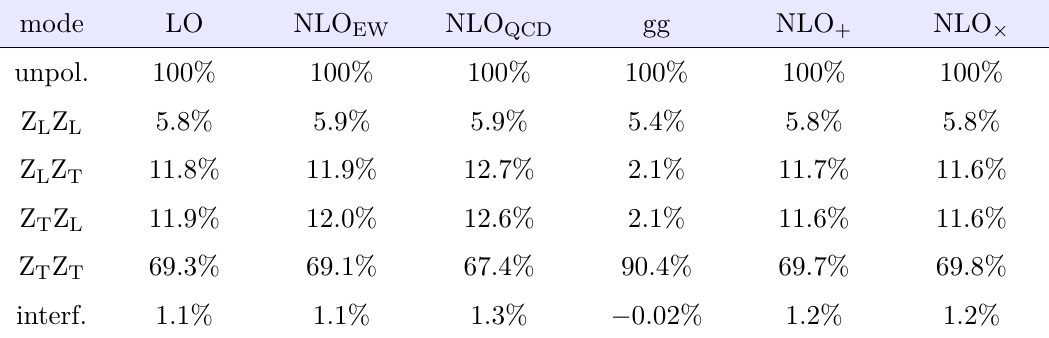
Table 4 . Polarization fractions in the fiducial setup (see section 2.5) for ZZ production at the LHC at LO and NLO accuracy, shown as percentages relative to the DPA unpolarized result. Polarizations are defined in the CM